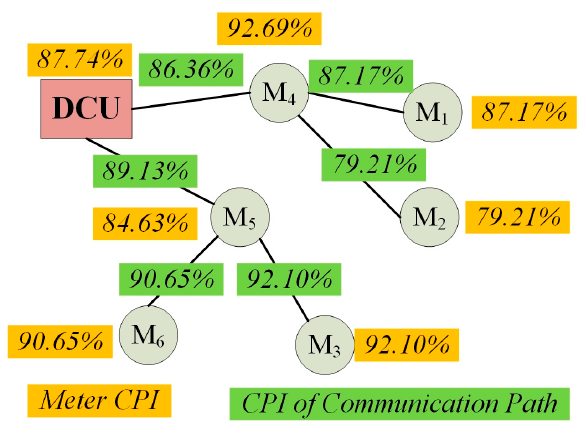
Figure 13. CPIs for the Six-Meter Case after Communication Path Changed.